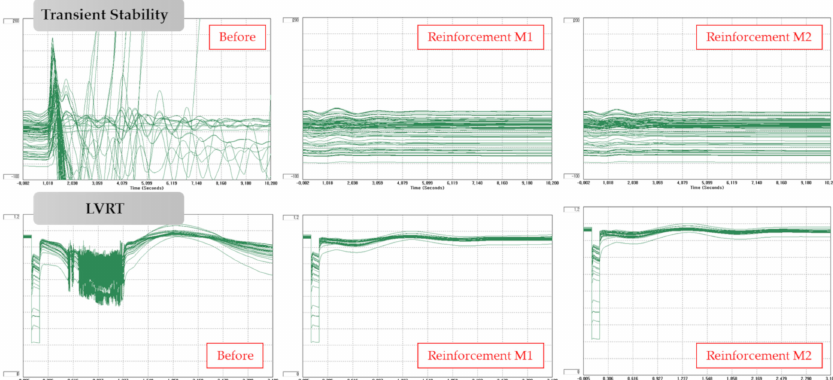
Figure A10. Plots for the rotor angle for the transient stability and voltage in the LVRT analysis according to the reinforcement